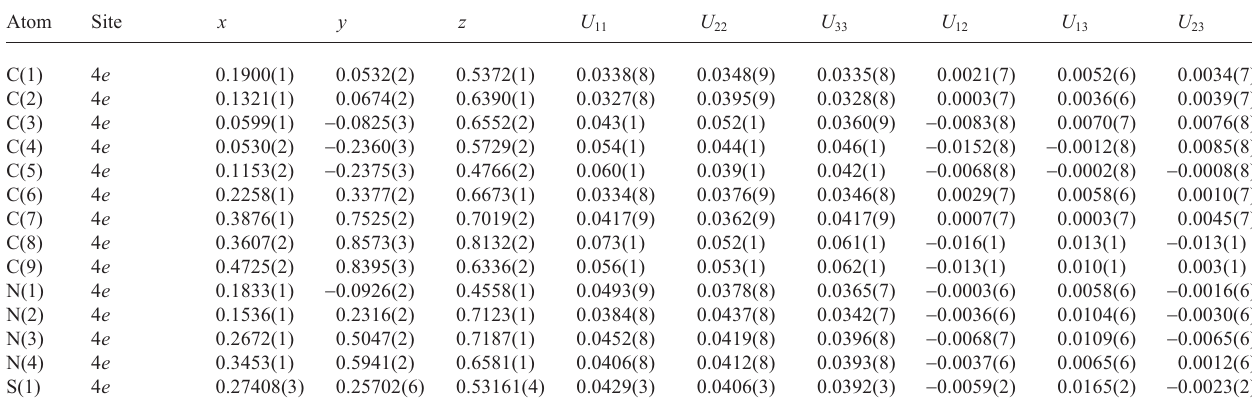
Table 3. Atomic coordinates and displacement parameters (in Å 2 )